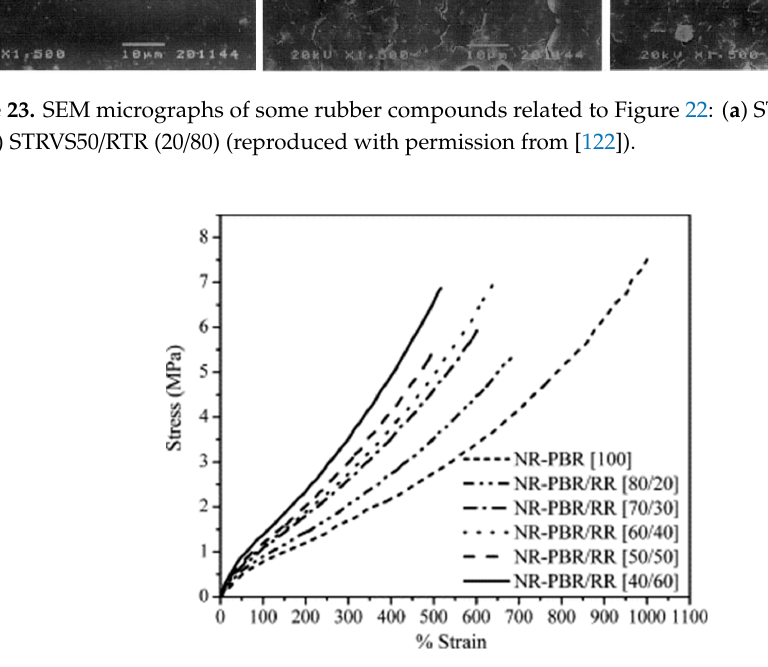
Figure 24. Stress-strain behavior of NR-PBR / RR blends (reproduced with permission from [121]).